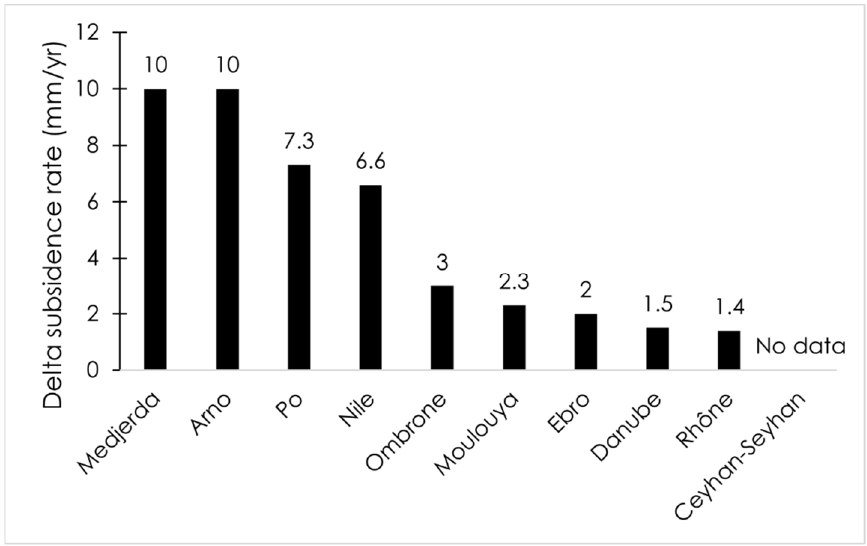
Figure 8. Mean subsidence rates for the ten deltas collated from a synthesis by [8].